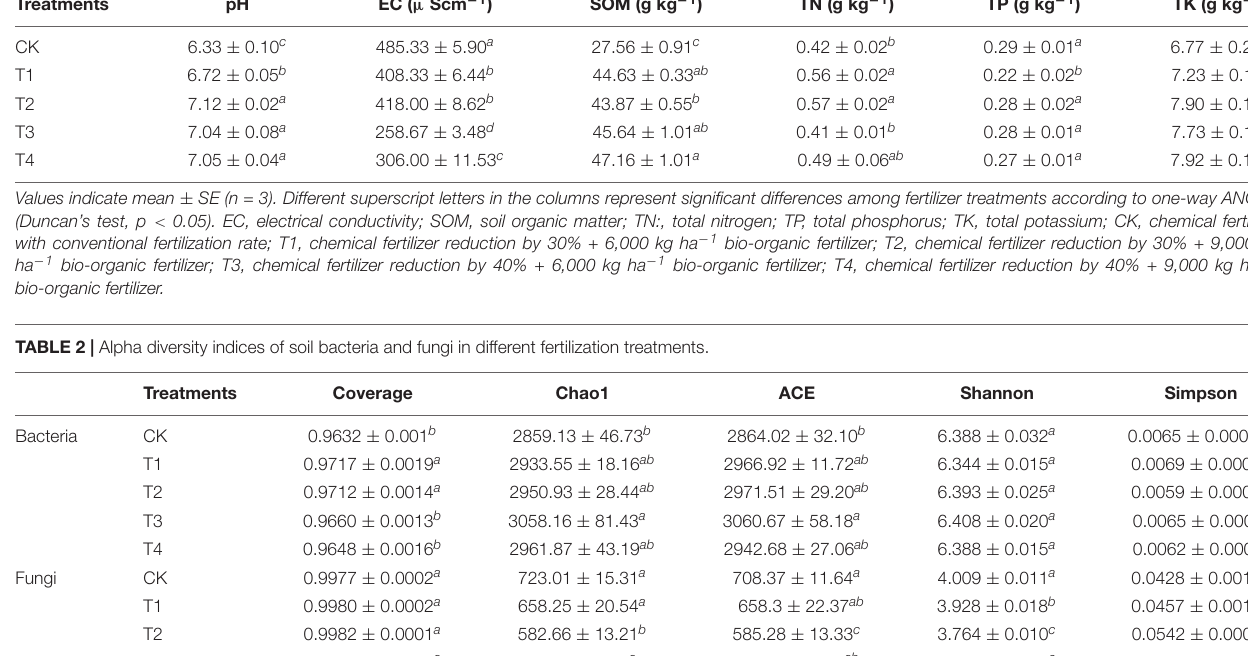
TABLE 1 | Soil chemical properties with different fertilization treatments. Treatments